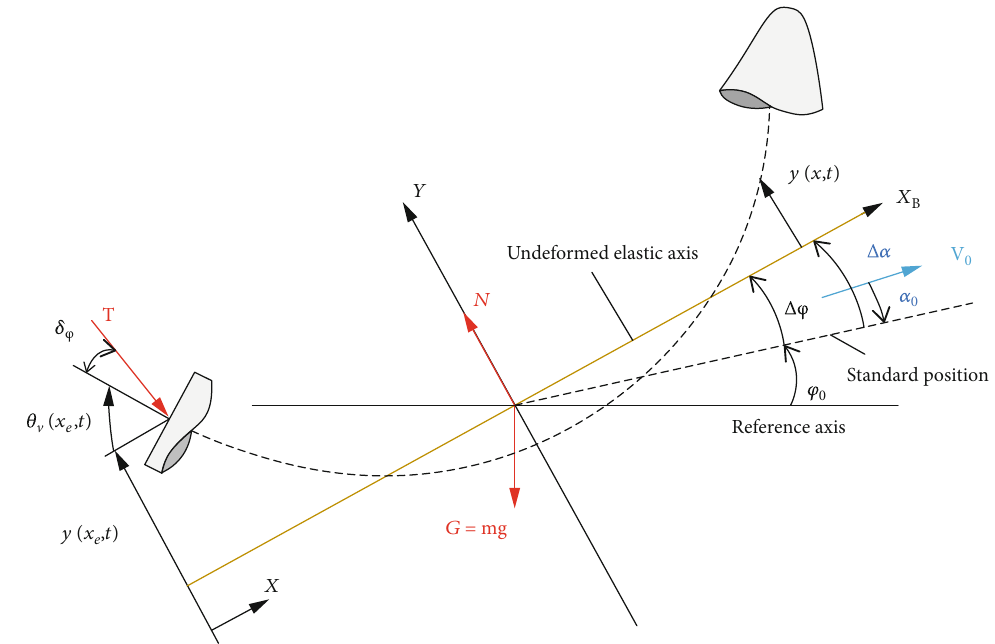
Figure 4: Disturbance coe ffi cient of an elastic rocket in the pitch